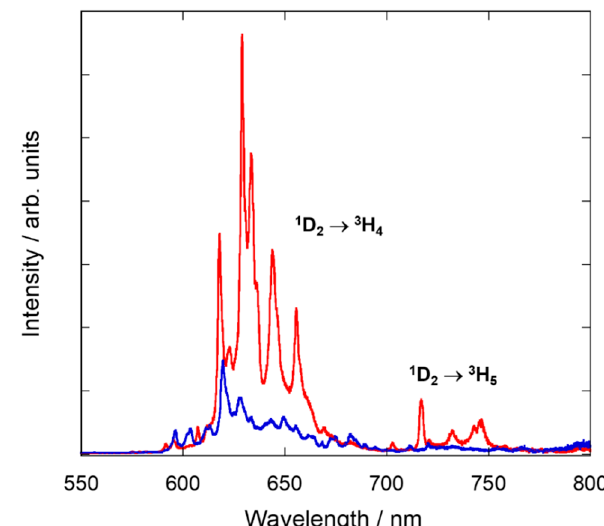
Figure 8. TEM image of Y 2 O 3 : Pr 3+ NCs obtained by solvothermal method at 220 °C followed by calcination at 1000 °C for 4 h.